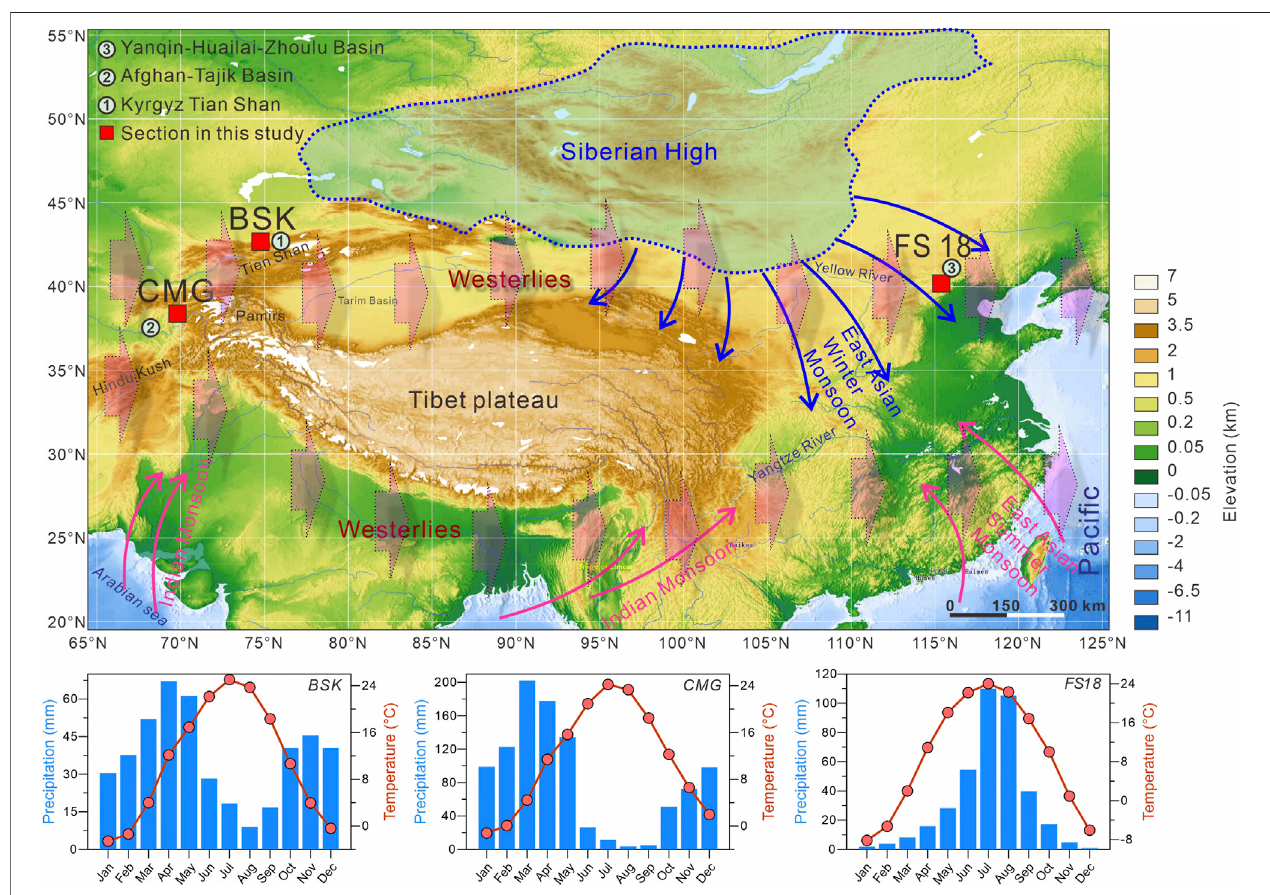
FIGURE 1 | Locations of the studied loess sections and monthly precipitation and temperature at the sampling sites.